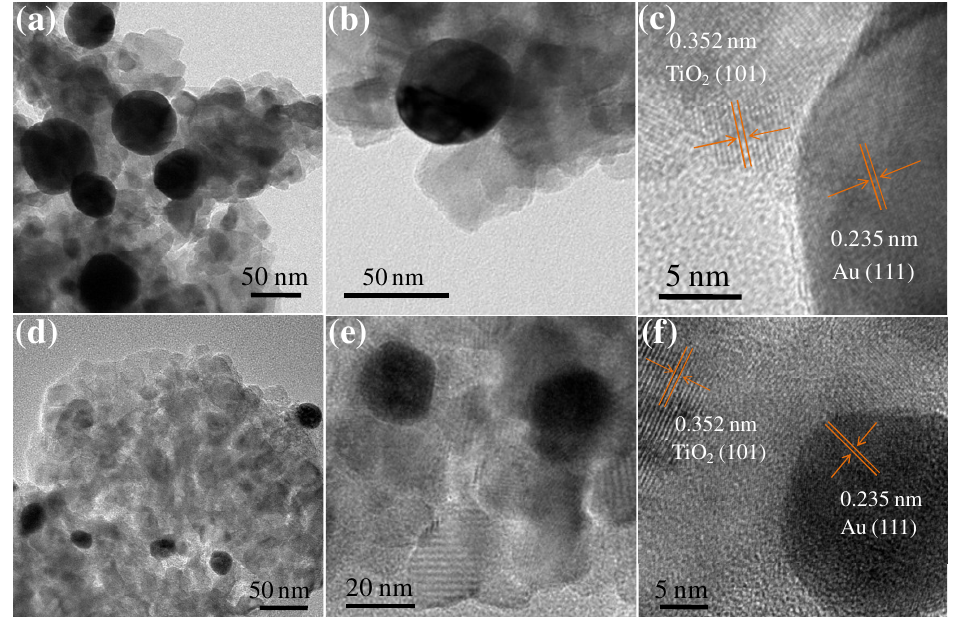
Figure 1. ( a , b ) Transmission electron microscopy (TEM) and ( c ) high resolution TEM (HRTEM) photographs of large AuNPs/TiO 2 hybrids. ( d , e ) TEM and ( f ) HRTEM photographs of small AuNPs/TiO 2 composites.